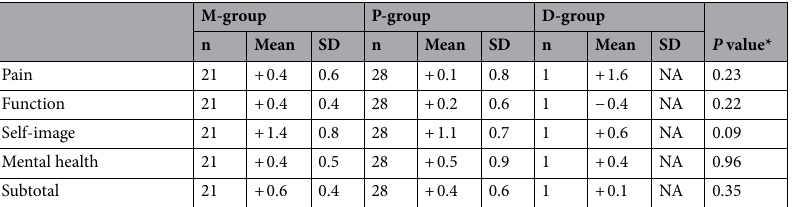
Table 2. Patient characteristics, radiographic data, and SRS-22r scores among the test groups. *M-group versus P-group. UIV upper instrumented vertebra, MSLV modified Shinshu line vertebra, PT proximal thoracic, MT main thoracic, C7PL-CSVL absolute length between C7 plumb line and central sacral vertical line, CA clavicular angle, |RSH| absolute radiographic shoulder height, AVT apical vertebral translation, SRS- 22r Scoliosis Research Society 22r questionnaire, NA not